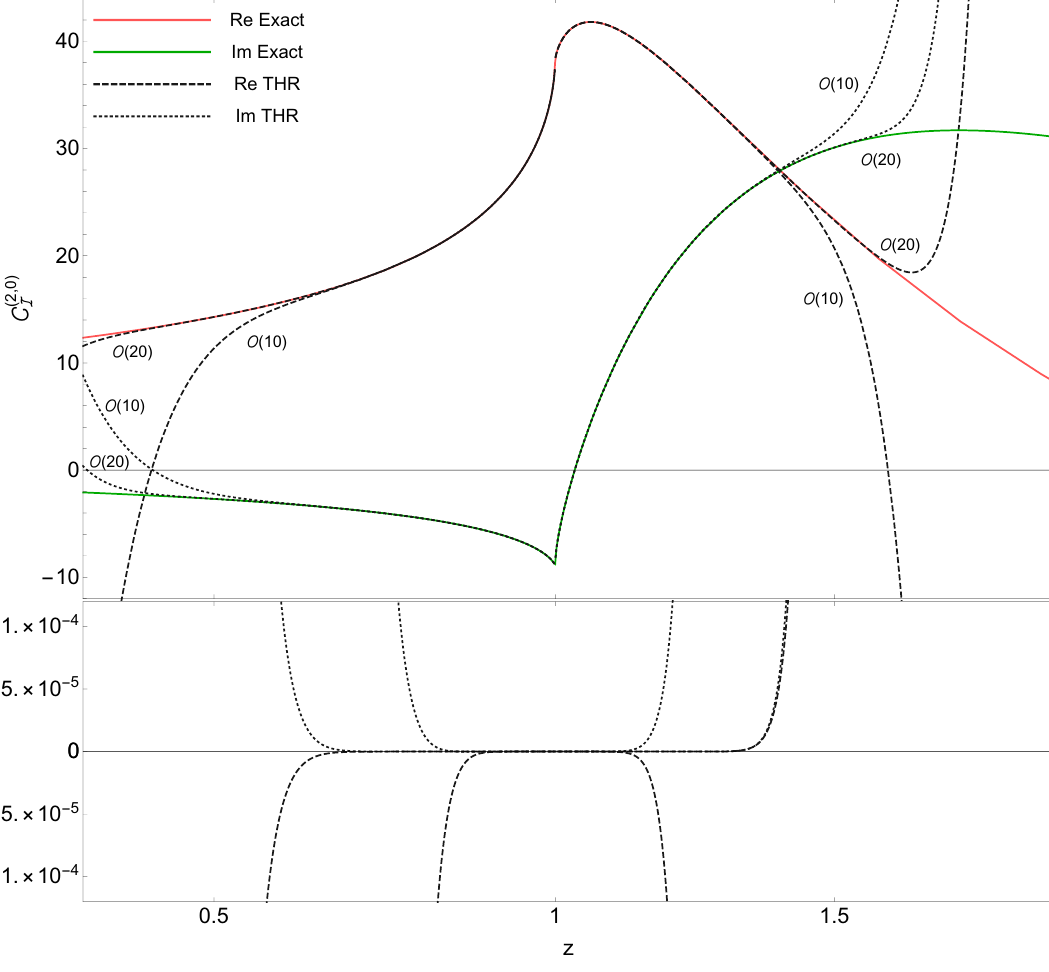
Figure 7 . Comparison of the threshold expansion (THR) truncated at O (cid:0) (cid:1) O (1 (cid:0) z ) 20 with the exact result for the three-loop coe(cid:14)cient of the (cid:12)nite remainder C (2) n l = 0, L (cid:22) = 0. The lower panel shows the absolute di(cid:11)erence between the expansions and the exact